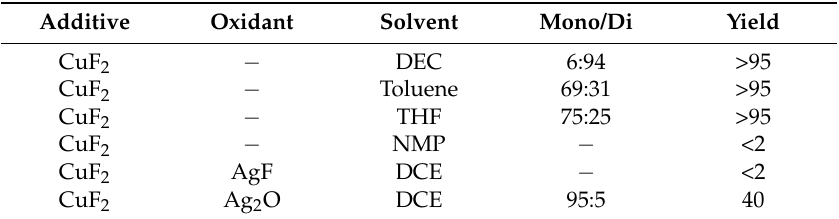
Table 1. Solvent and oxidant effects on mono-diarylated product formation in the arylation of 2-phenylpyridine with aryl